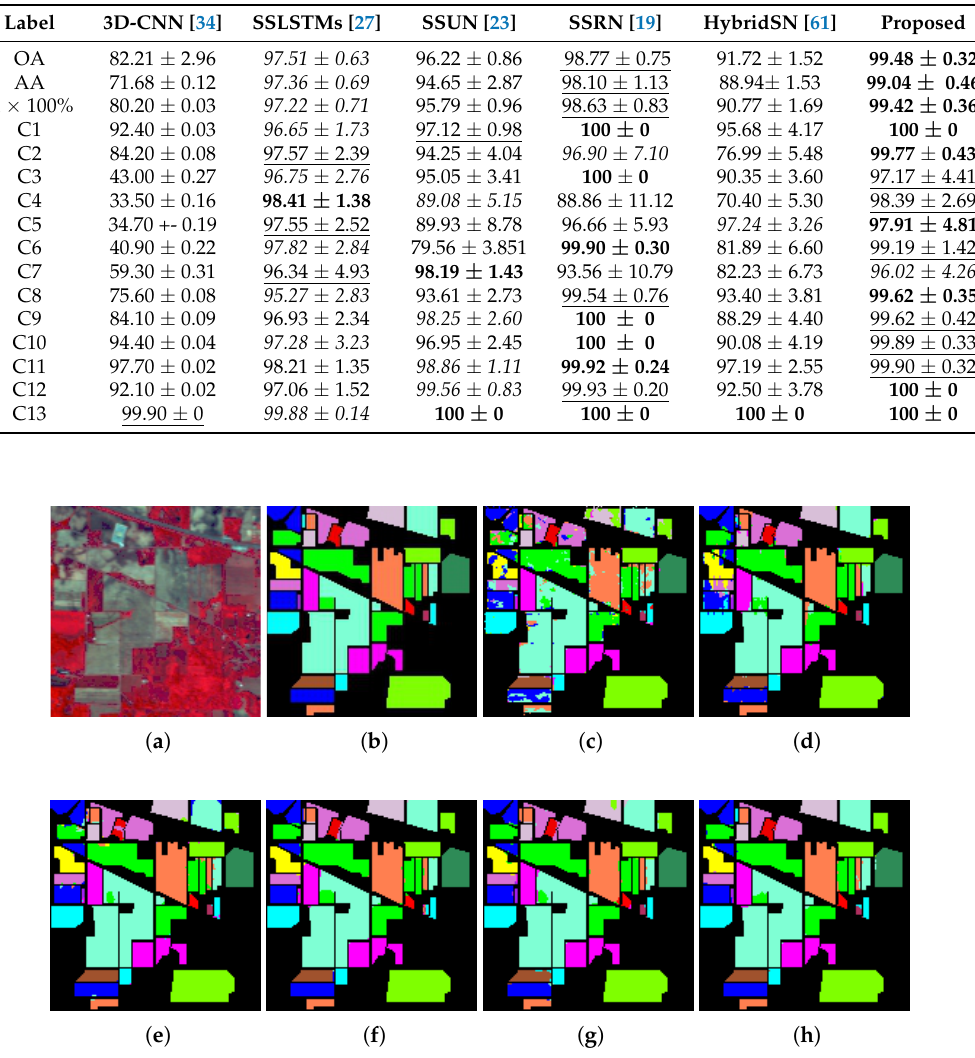
Figure 6. The classification map of IP dataset. ( a ) False color image, ( b ) Ground truth, and ( c – h ) Prediction classification maps of 3D-Convolutional Neural Network (CNN) (85.29%), spectral-spatial long short-term memory (SSLSTMs) (95%), spectral-spatial unified network (SSUN) (97.24%), SSRN (98.29%), HybridSN (97.38%), and our proposed architecture